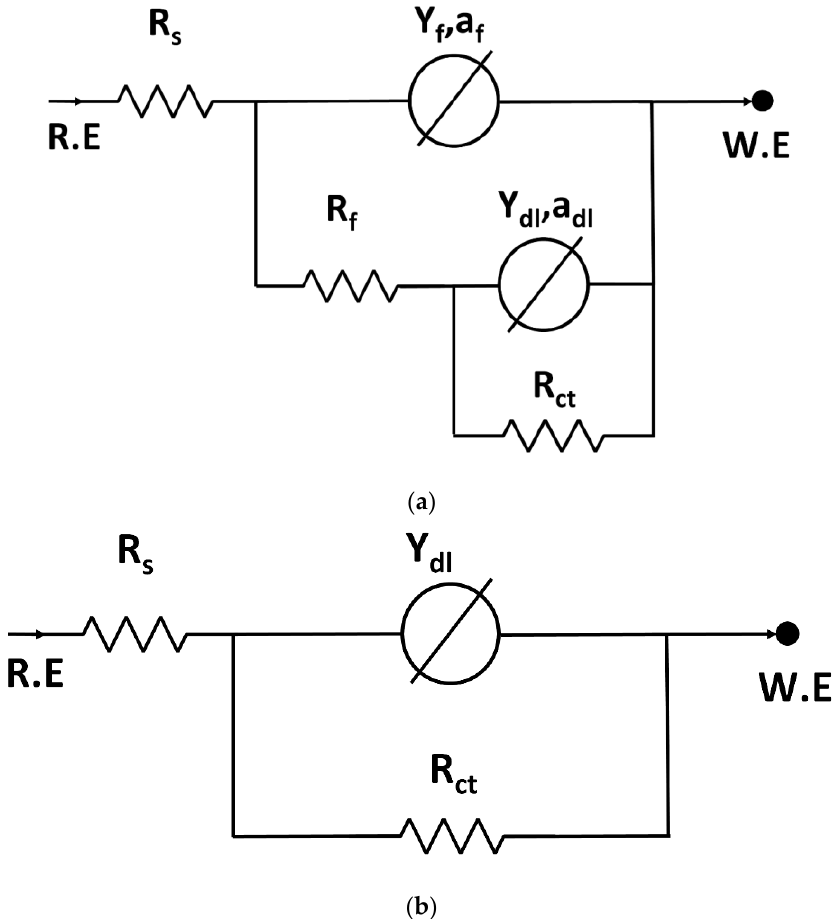
Figure 9. The equivalent circuits for ( a ) water-quenched, and ( b ) air-cooled part of the block. Table 3. Corrosion parameters of the quenched AA7075-T6 block .